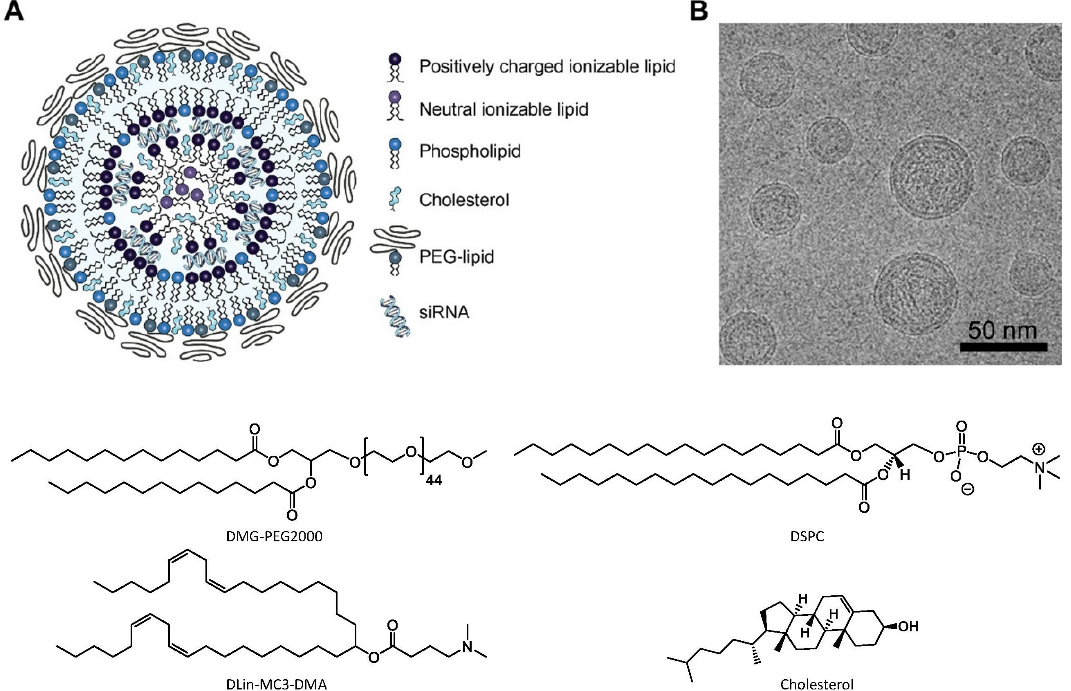
Figure 30. Once taken up by the liver cells through endocytosis, the escape of siRNA from the endosomes is promoted by interactions between positively charged DLin-MC3-DMA molecules, which interact with negatively charged endogenous lipids, resulting in endo- some-disrupting, inverted, non-bilayer forming structures (pair of cationic and anionic li- pids that have the propensity to form inverted micelles, with packing parameter p > 1) [425].